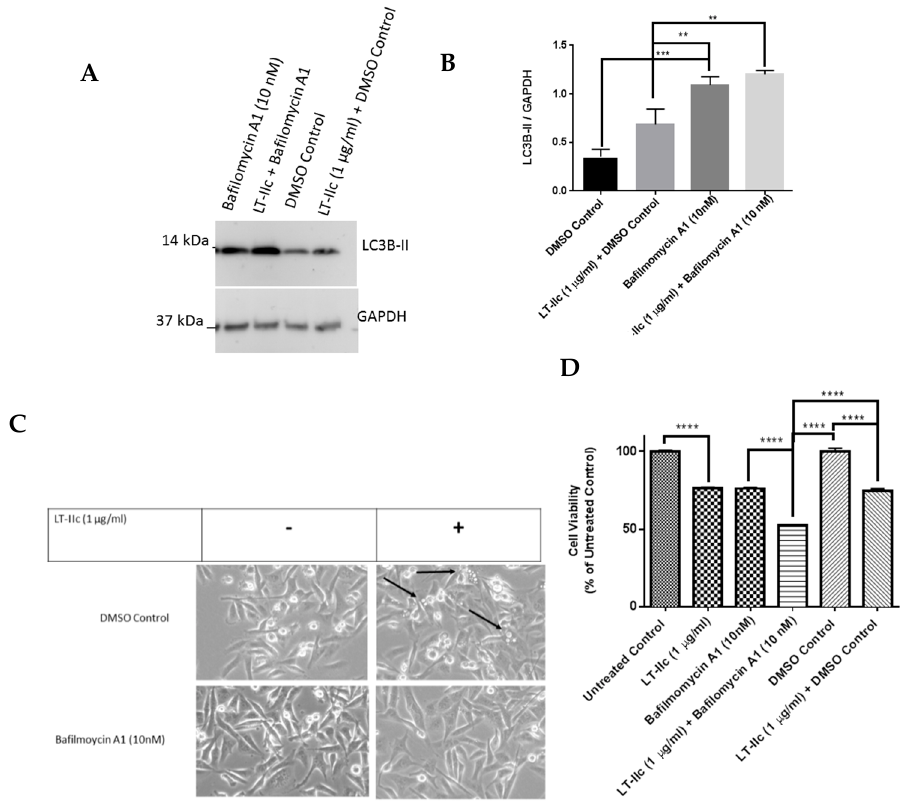
Figure 6. Effects of bafilomycin A1 on LT-IIc efficacy in MDA-MB-231 cells. ( A ) MDA-MB-231 cells were treated with LT-IIc (1 µg/mL) in the presence or absence of bafilomycin A1 (10 nM) for 48 h. ( B ) The level of expression of LC3B-II was analyzed using Western blotting and the blots were quantified using ImageJ software. ( C ) MDA-MB-231 cells were treated with LT-IIc (1 µg/mL) in the presence or absence of bafilomycin A1 (10 nM) for 24 h and cell morphology was evaluated using microscopic analysis (10× magnification). Arrows indicate vacuoles observed in LT-IIc treated cells not exposed to bafilomycin A1. ( D ) Bafilomycin A1 and LT-IIc showed similar effects on MDA-MB-231 cytotoxicity (measured by MTT assay). Co-treatment significantly enhanced cytotoxicity (compared to LT-IIc plus DMSO control). All panels represent at least three independent replicates from three independent experiments. Bars represent means ± standard error of the mean. ** p < 0.01; *** p < 0.0001; **** p < 0.00001.